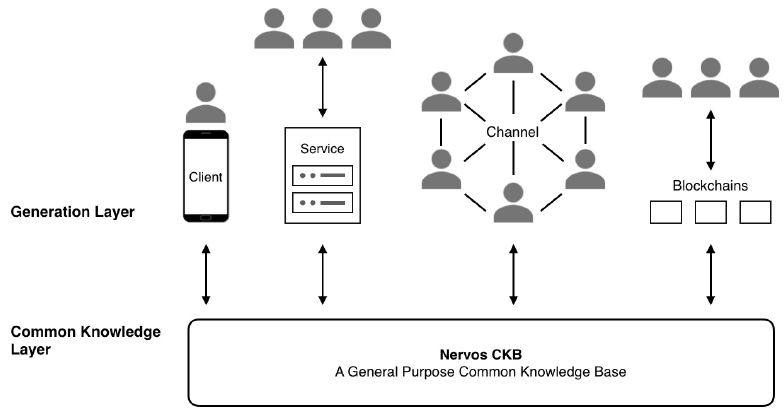
Figure 1. The CKB layered